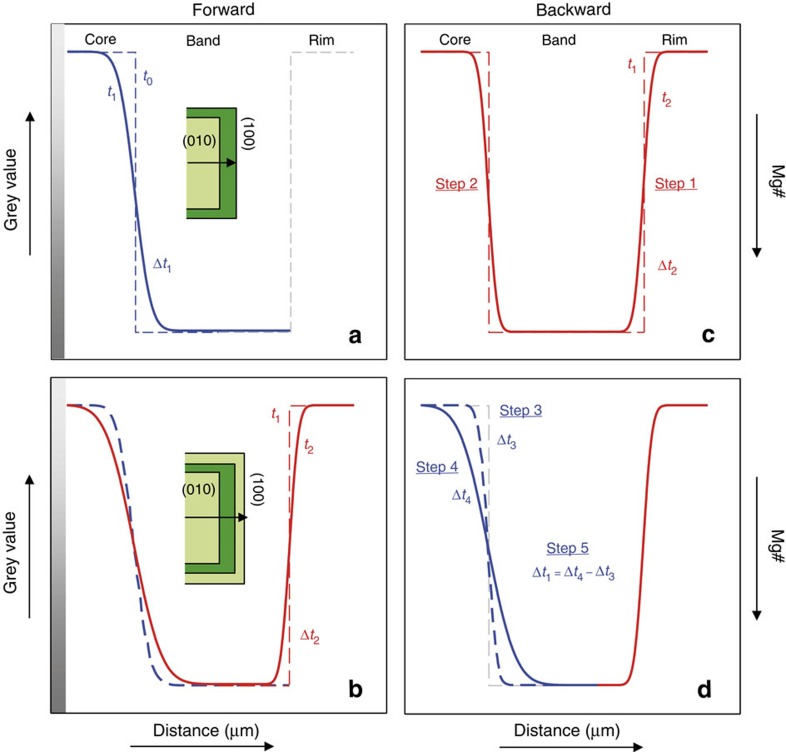
Conceptual description of the Non-Isothermal Diffusion Incremental Step model.Fe–Mg compositional zoning profiles are measured perpendicular to the (100) plane (black arrow in a,b) of the schematic clinopyroxene (light green=low Mg#—high grey value; dark green=high Mg#—low grey value). Y-axis=contrast in grey value and Mg# (left and right hand side) across the boundary layers; x-axis=extent of diffusion in μm. Forward model: (a) development of the compositional zoning from the instantaneous dark band growth at t0 (dashed blue line) to the time t1 spent at T1 °C (solid blue line). The dashed grey line represents the initial dark band—rim conditions yet to be formed; (b) clinopyroxene rim instantaneous growth at t1 (dashed red line) and proceeding Fe–Mg diffusion at T2 °C (solid red line), with T2<T1, until the eruption at t2. Fe–Mg diffusion is not limited to the dark band—rim boundary, but also affects the core—dark band boundary. The dashed blue line corresponds to the diffusion profile developed at T1 °C in the Δt1 time span (solid blue line in a). Backward model: (c) the dashed red line represents the initial boundary conditions of Step 1 and 2 at T2 °C, whilst the solid red line is the core—dark band—rim Fe–Mg diffusion profile at T2 °C developed during Δt2; (d) the solid red line is the final dark band—rim profile developed during Step 1 and corresponds to the compositional profile in b, whilst the solid blue line is the final Fe–Mg diffusion profile developed at T1 °C during Δt4, and corresponds to the actual compositional profile in b. The initial core—dark band conditions are represented by the dashed grey line. The dashed blue line is the fictitious Fe–Mg diffusion profile developed at T1°C (>T2), during Δt3 and corresponds to the profile developed at T2 °C in c (Step 2, solid red line). The clinopyroxene resident time at T1 °C is Δt1=Δt4−Δt3, and the total crystal residence time is given by Δt1+Δt2.